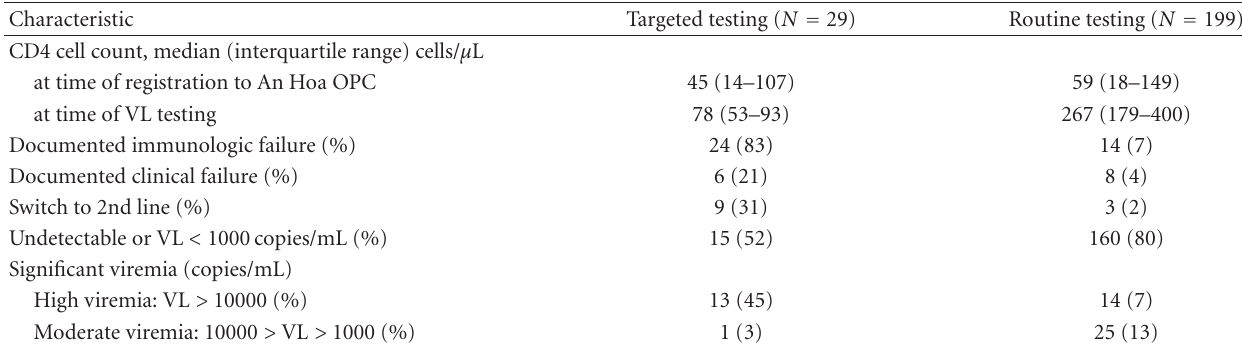
Table 3: Characteristics of patients on ART > 1yr—targeted testing and routine testing.